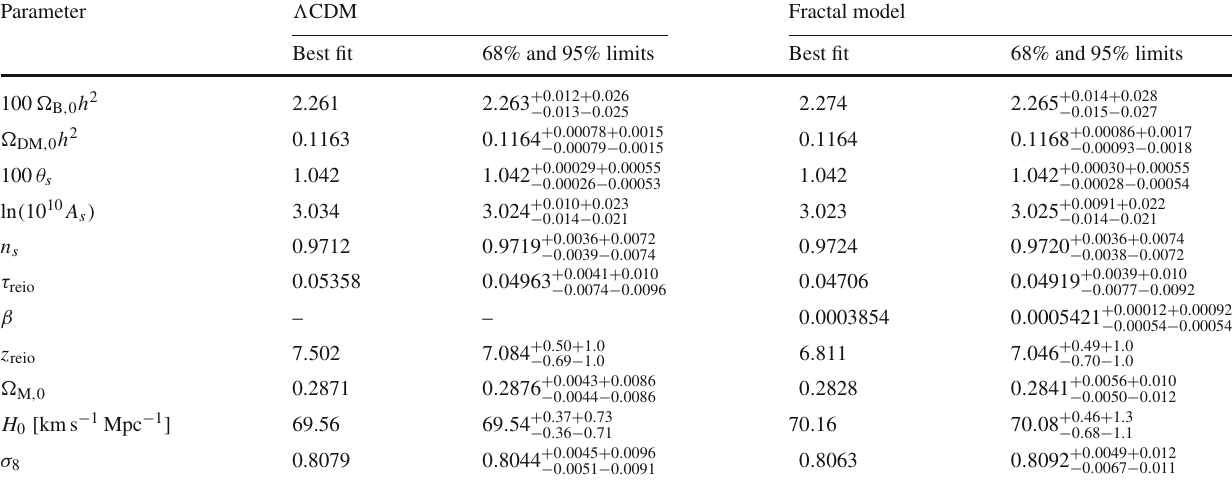
Table 1 Best fit values and 68% and 95% confidence limits for cosmological parameters from “Planck + Planck-SZ + CFHTLenS + Pan- theon + BAO + BAORSD” data set for (cid:3) CDM and fractal model Parameter